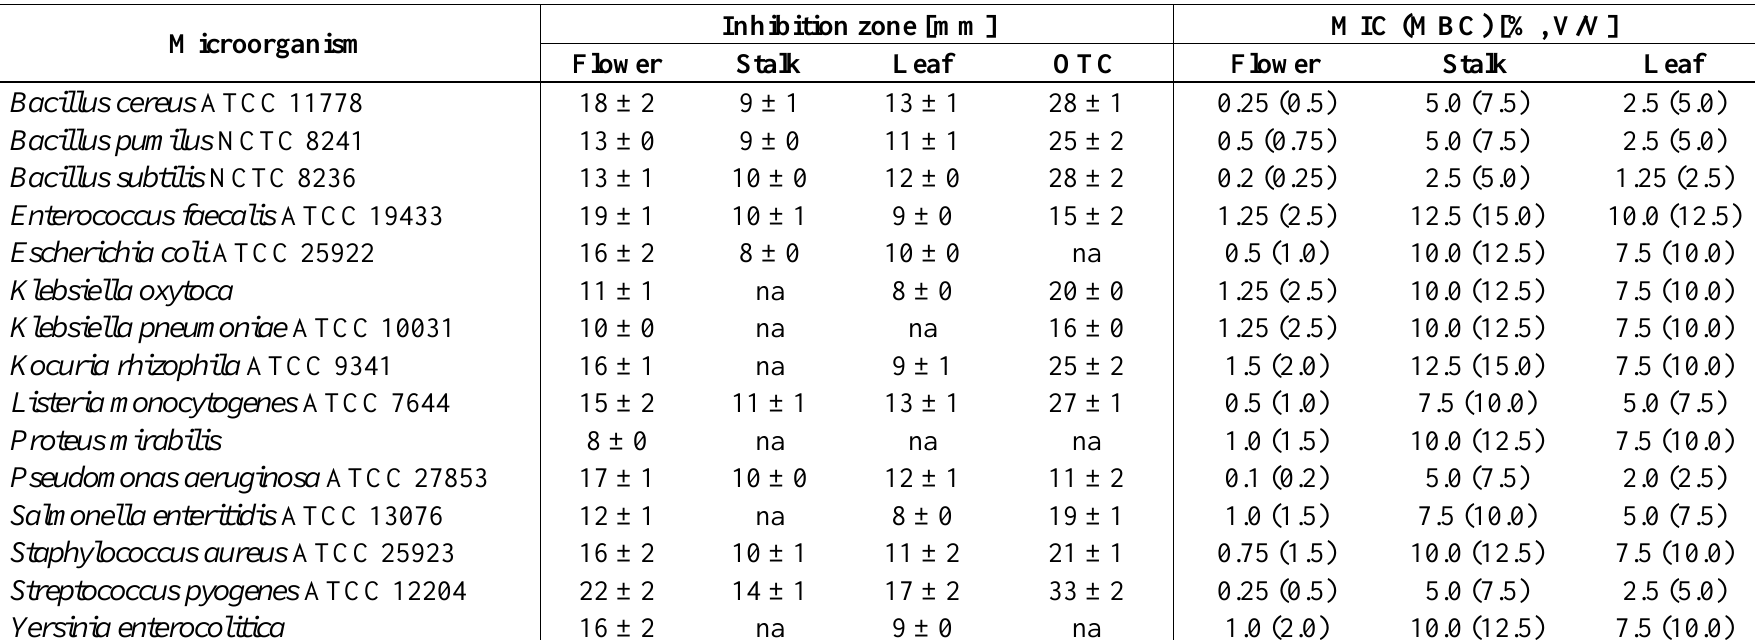
The results of diffusion method are presented as diameters of inhibition zones in mm. Each value represents mean ± SD (n = 3). Minimal inhibitory concentrations (MIC) and minimal bactericidal concentrations (MBC) of fluid extract were determined by broth dilution assay and results are expressed as volume percentage (%, V/V). Oxytetracycline (OTC) was used as positive control; na: no